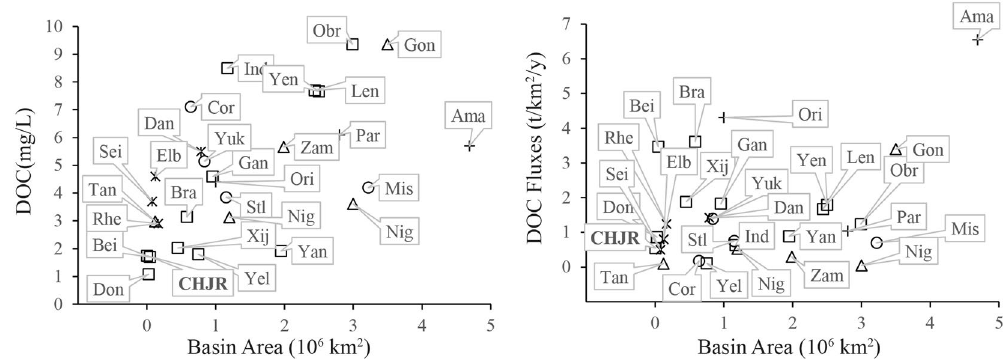
Figure 2. The DOC concentration, DOC Fluxes and basin area of the major rivers in global. (Yan = Yangtze River 13 ; Yel = Yellow River 3 ; Bra = Brahmaputra 3 ; Gan = Ganges River 3 ; Ind = Indus River 3 ; Ori = Orinoco River 3 ; Par = Paraná River 3 ; Zam = Zambezi river 3 ; Nil = Nile River 3 ; Dan = Danube River 3 ; Sei = Seine 3 ; Xij = Xijiang River 10 ; Don = Dongjiang River 23 ; Bei = Beijiang River 24 ; CHJR, This study; Len = Lena River 25 ; Obr = Ob River 26 ; Yen = Yenisei River 26 ; Cor = Colorado River 27 ; Mis = Mississippi River 28 ; Stl = St Lawrence River 29 ;Yuk = Yukon River 30 ; Ama = Amazon River 31 ; Con = Congo River 31 ; Nig = Niger River 31 ; Tan = Tana River 32 ; Elb = Elbe 33 ; Rhe = Rhein 33 ).